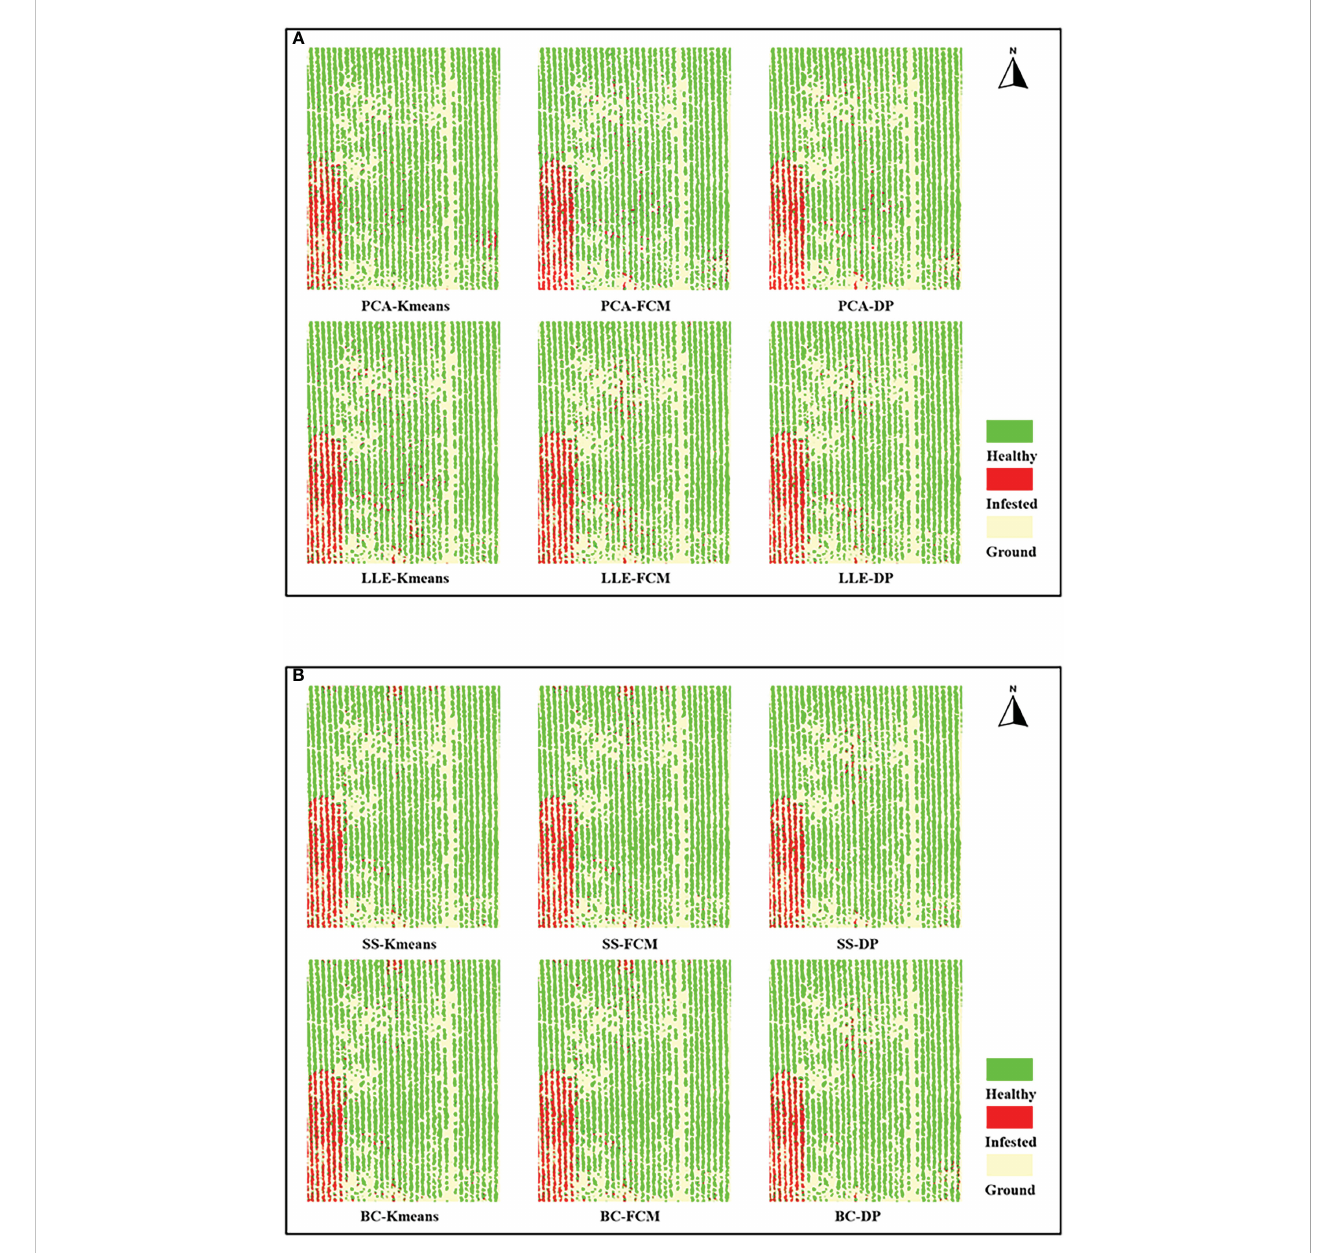
FIGURE 9 Recognition results mapping of jujube spider mite infestations. (A) Recognition results mapping of feature extraction models, (B) Recognition results mapping of feature selection